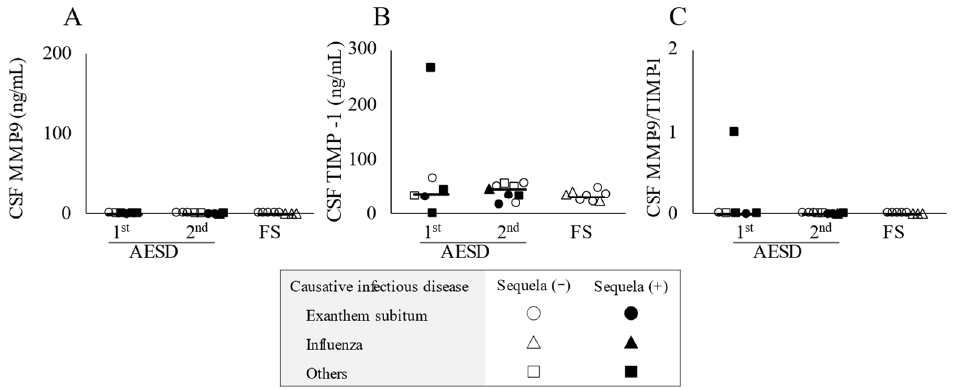
Figure 2. Cerebrospinal fluid (CSF) concentrations of the biomarkers in patients with acute encephalopathy with biphasic seizures and late reduced diffusion (AESD) in the 1st or 2nd seizure phase or with prolonged febrile seizure (FS). CSF levels of matrix metalloproteinase-9 (MMP-9) ( A ) and tissue inhibitor matrix metalloproteinase-1 (TIMP-1) ( B ) and the MMP-9/TIMP-1 ratio in CSF ( C ) in all patients with AESD or prolonged FS. Statistical comparisons by the Tukey–Kramer or Steel–Dwass test. Circles, triangles, and squares represent patients with AESD or FS due to exanthem subitum, influenza, and other infectious diseases, respectively. Filled marks donate patients with sequela (e), and open marks without sequela.